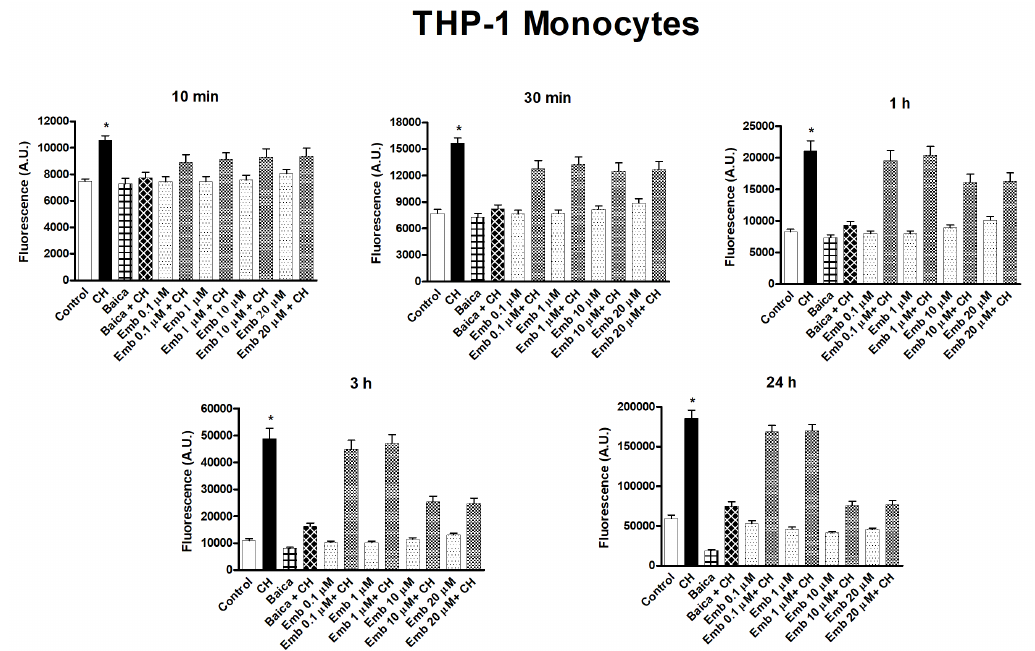
Figure 17. Time course of embelin capability to protect toward oxidative stress given by Cumene hydroperoxide in THP-1 monocytes. The concentration of cumene hydroperoxide (CH) was 200 µ M